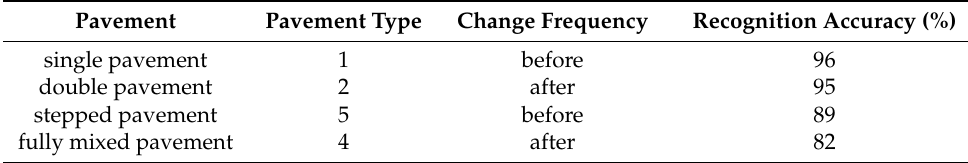
Table 6. Recognition accuracy of different pavements.